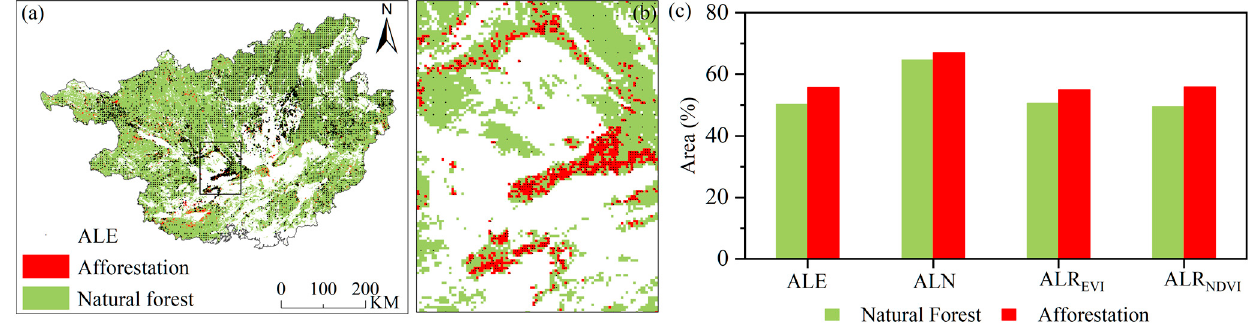
Figure 7. ( a ) The spatial distributions of ALE, afforestation and natural forest in 2012; ( b ) close-up of the rectangle in ( a ); ( c ) the area proportion of ALE, ALN, ALR EVI , ALR NDVI between afforestation and natural forest.